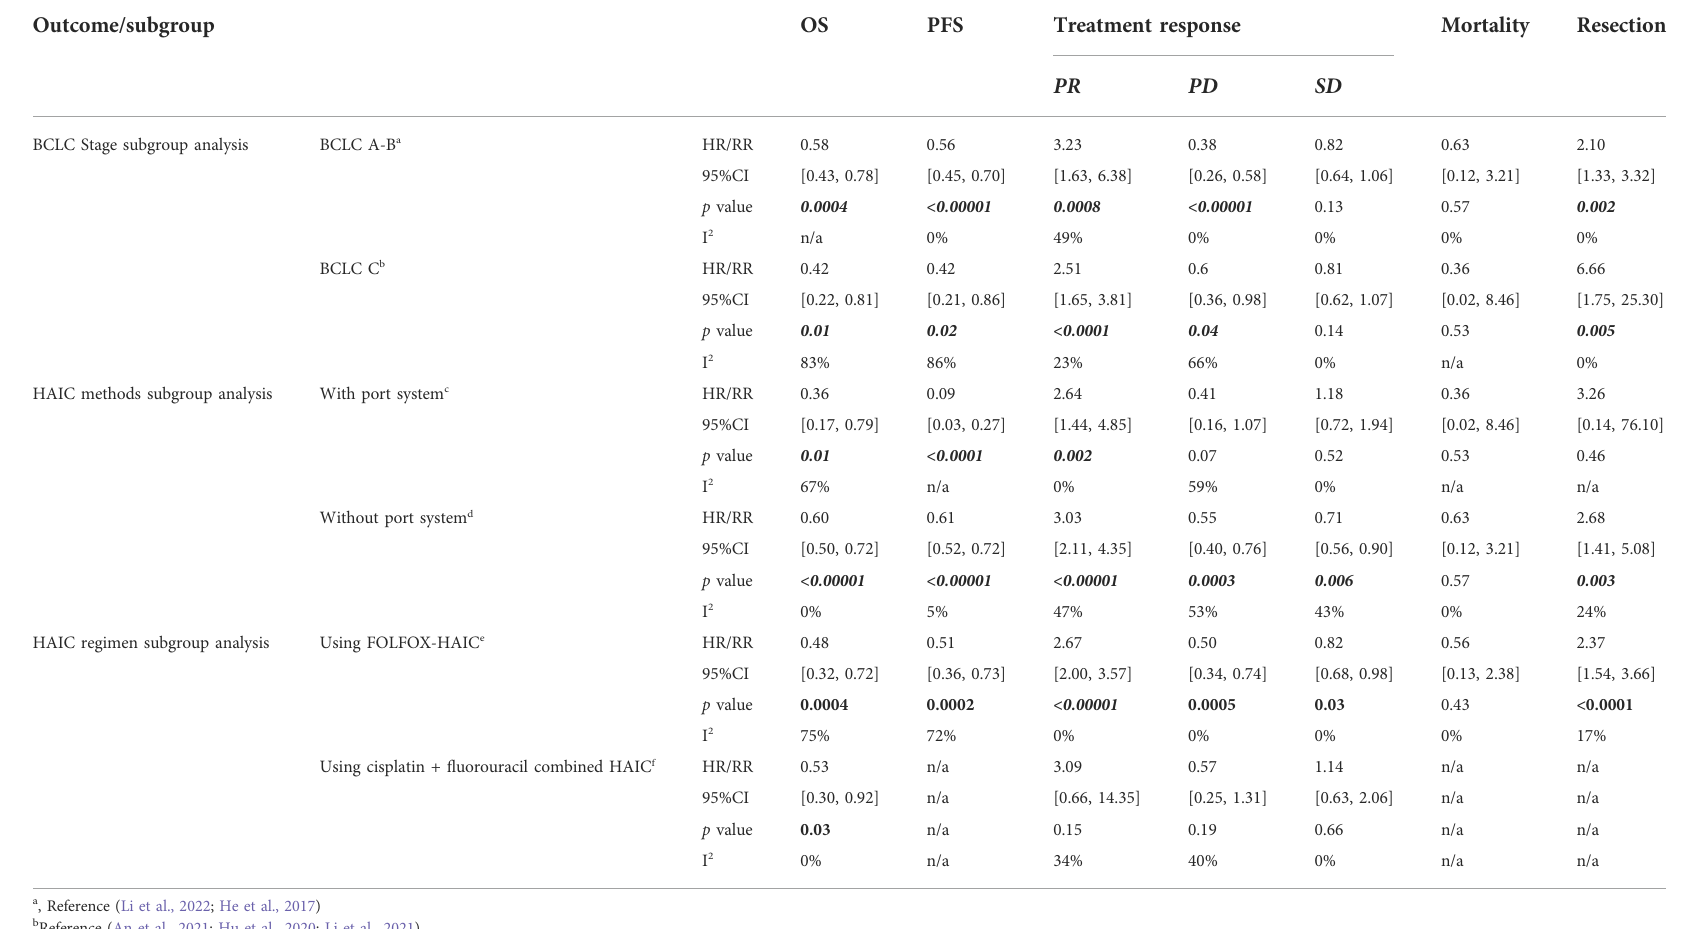
TABLE 3 Subgroup analysis of